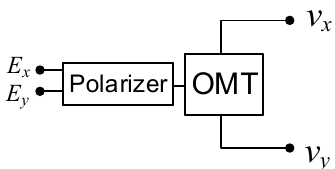
Figure A3 . Scheme with the four electrical ports of the polarizer-OMT assembly.